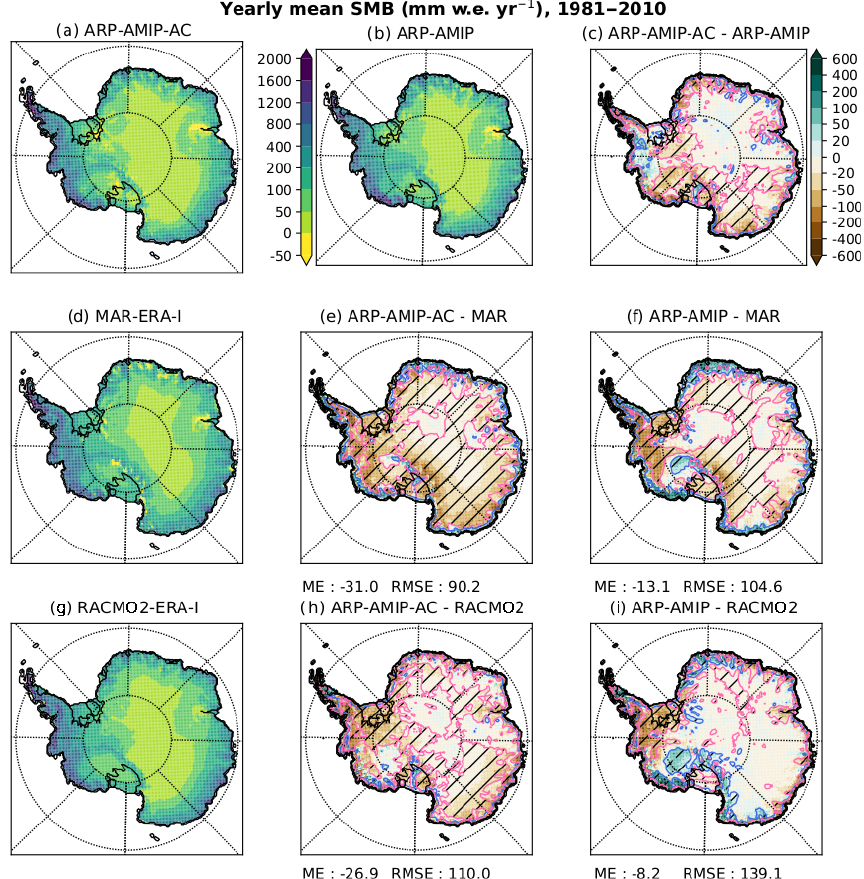
Figure 6. Yearly mean total SMB (mmw.e.yr − 1 ) for ARP-AMIP-AC (a) , ARP-AMIP (b) , MAR-ERA-I (d) and RACMO2-ERA-I (g) for the reference period 1981–2010. Difference (mmw.e.yr − 1 ) for ARP-AMIP-AC minus ARP-AMIP (c) , ARP-AMIP-AC minus MAR-ERA-I (e) , ARP-AMIP minus MAR-ERA-I (f) , ARP-AMIP-AC minus RACMO2-ERA-I (h) and ARP-AMIP minus RACMO2-ERA-I (i) . Blue (magenta) hatched contour lines represent areas where the positive (negative) difference is larger than 20%. Mean error (ME) and RMSE statistics (mmw.e.yr − 1 ) for the comparison with MAR and RACMO2 are shown below the panel.